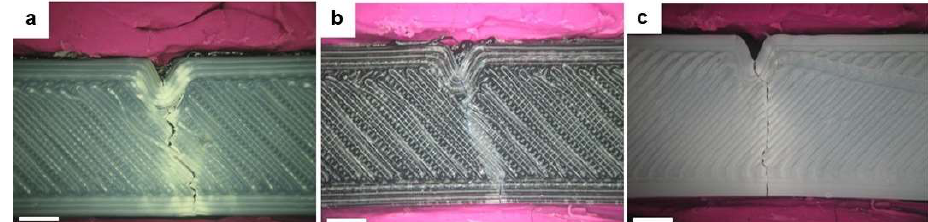
Figure 9. Surface damage of the as-printed sandwich-structured specimens after the transversal impact tests: ( a ) ABS_TPU_ABS, ( b ) PMMA_TPU_PMMA, and ( c ) HIPS_TPU_HIPS. Scale bar: 500 µm.